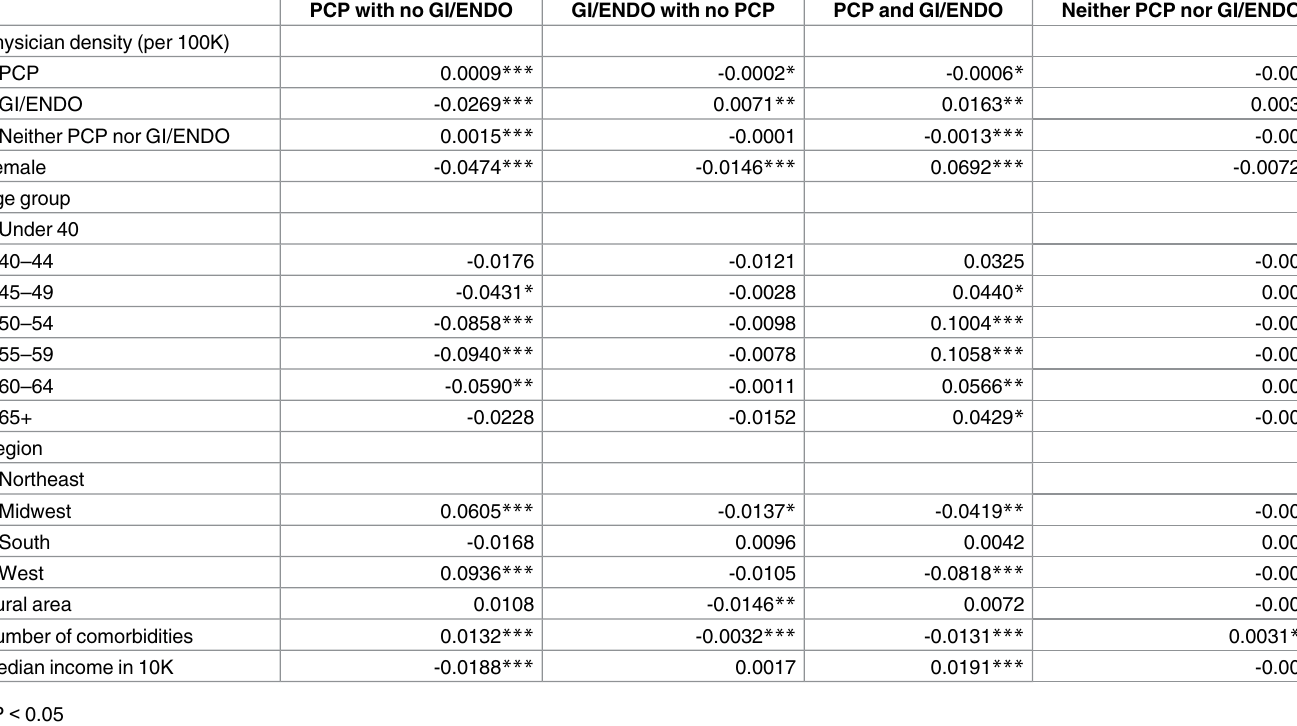
Table 3. Marginal effects on probability and 95% confidence interval of visiting different physician mix categories using multinomial probit